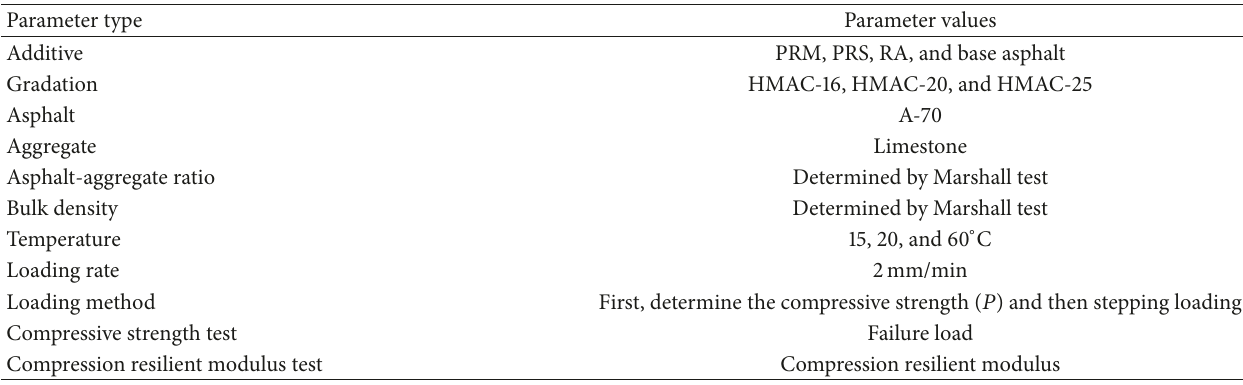
Table 5: Static modulus test